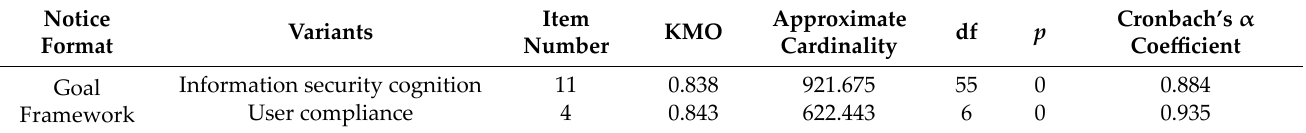
Table 9. Reliability and Validity Analysis Results.